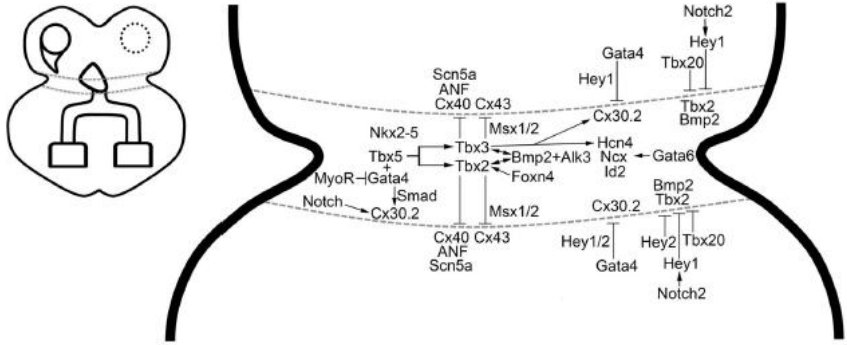
Figure 4. Atrioventricular canal/atrioventricular node gene regulatory network. Schematic overview of the cardiac conduction system, left panel; atrioventricular canal/node, right panel (reproduced with permission from [14]).